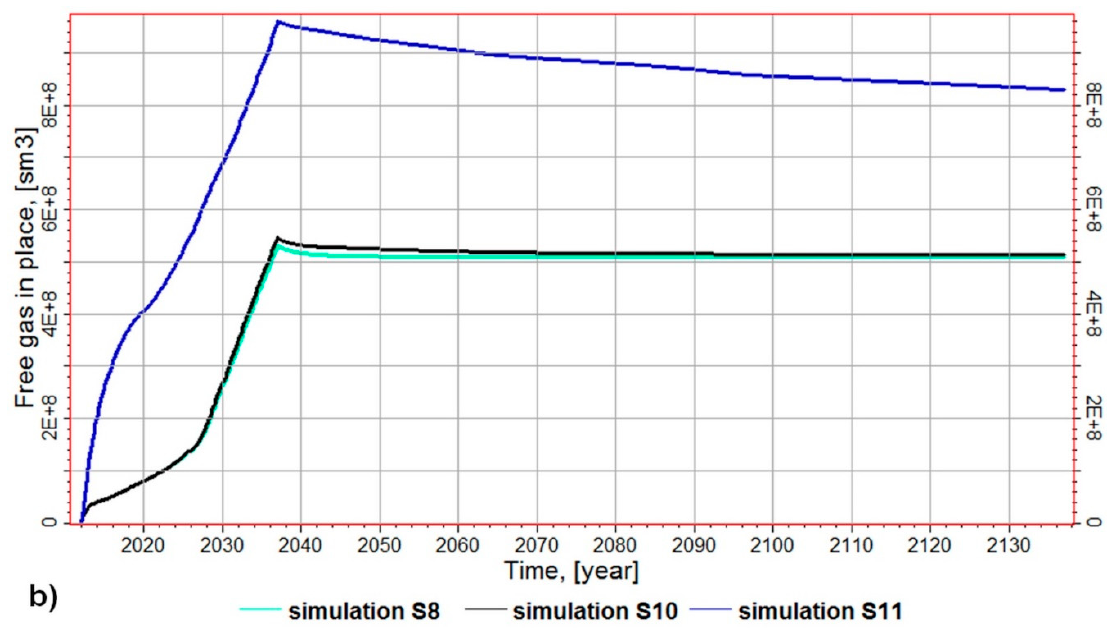
Figure 11. Comparison of changes in the average pressure over time in the injection zone ( a ) and the amount of free CO 2 in the structure ( b ) for three simulation variants: S8, S10, and S11.